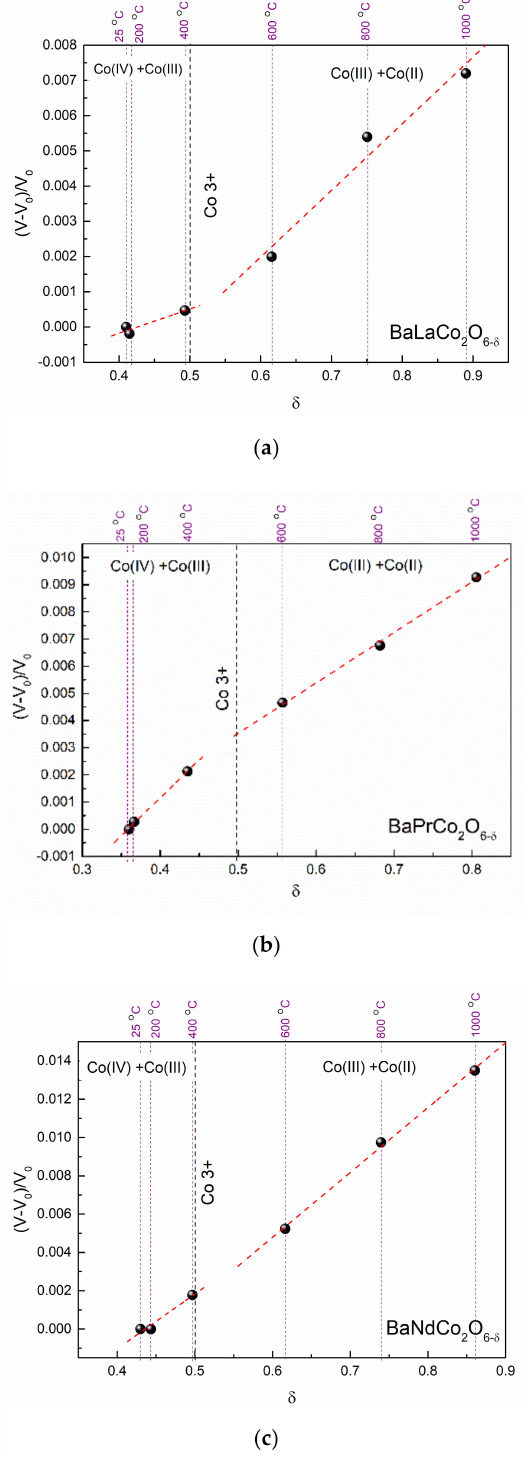
Figure 8. Relative change of unit cell volume from the chemical expansion of the orthorhombic phase as a function of oxygen non-stoichiometry for BLC ( a ), BPC ( b ), and BNC ( c ). Thermal expansion is